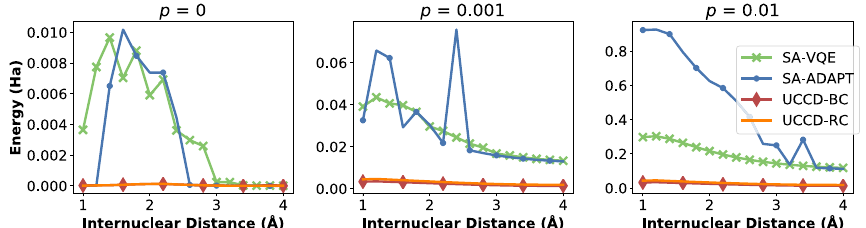
Fig. 10 The absolute error between the electronic energy of the simulated ansatze and the ground truth found through conventional means. All results shown use the COBYLA optimizer. Ansatze compared: singlet-adapted UCCSD VQE (SA-VQE), ADAPT-VQE with singlet-adapted UCCSD operator pool (SA-ADAPT), UCCD bare circuit (UCCD-BC), UCCD randomly compiled circuit (UCCD-RC)